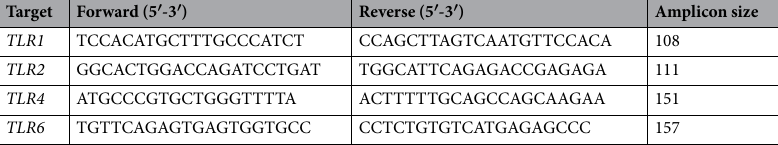
Table 1. Primers used to detect equine TLR s.